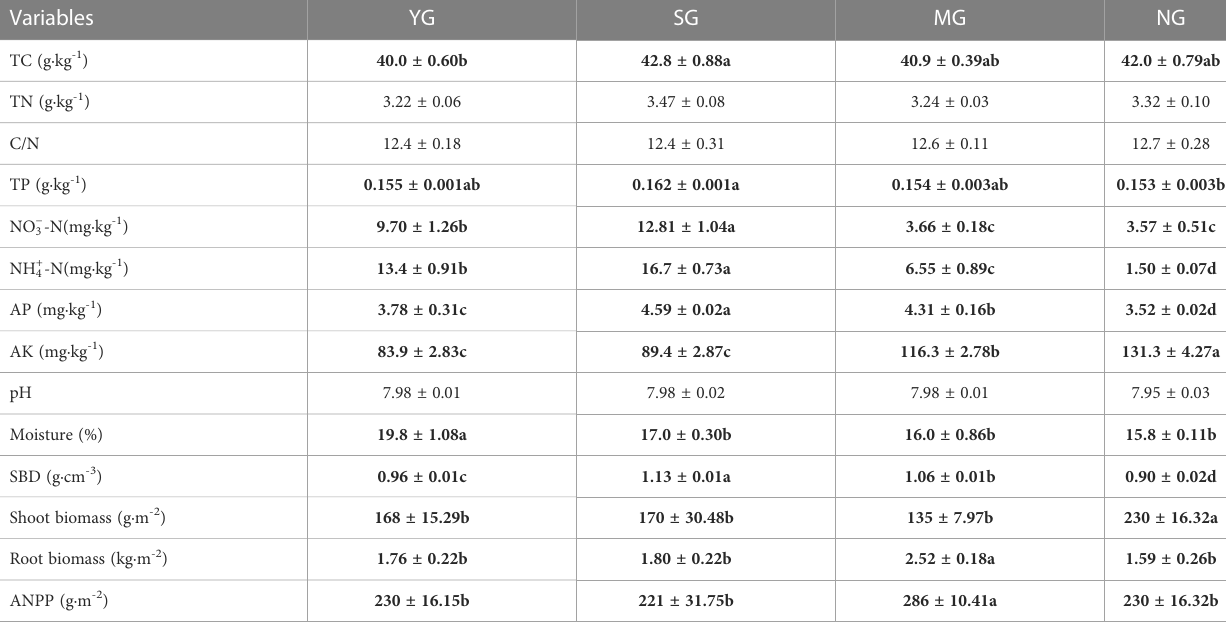
TABLE 1 Effects of herbivore assemblage on biotic and abiotic properties.